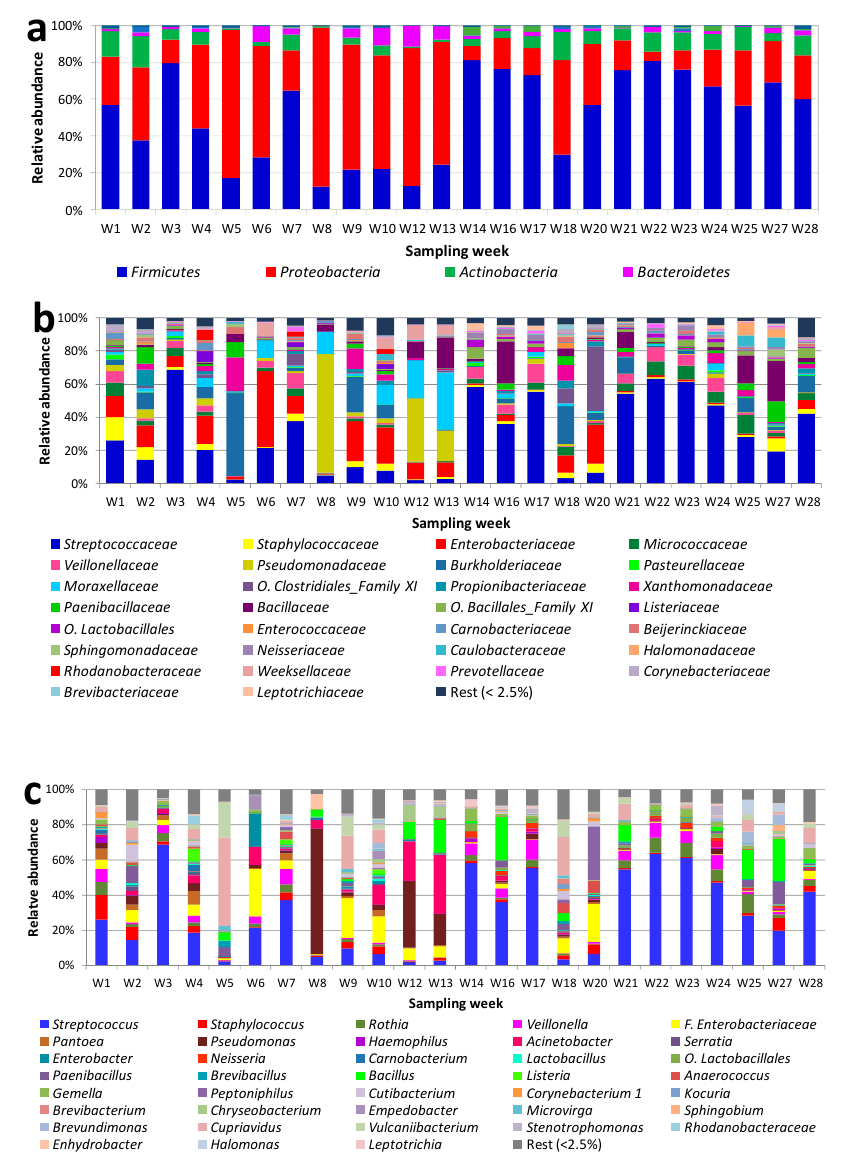
Figure 1. Bacterial diversity of breast milk samples at Phylum ( a ), Family ( b ) and Genus ( c ) levels. The di ff erent sampling weeks (W) are represented.